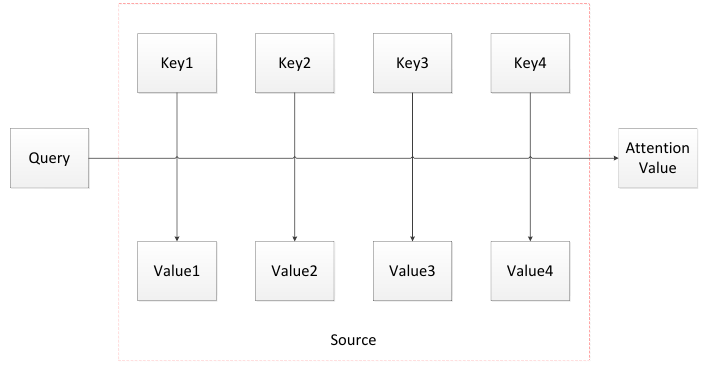
Figure 4. The Structure diagram of the attention mechanism.